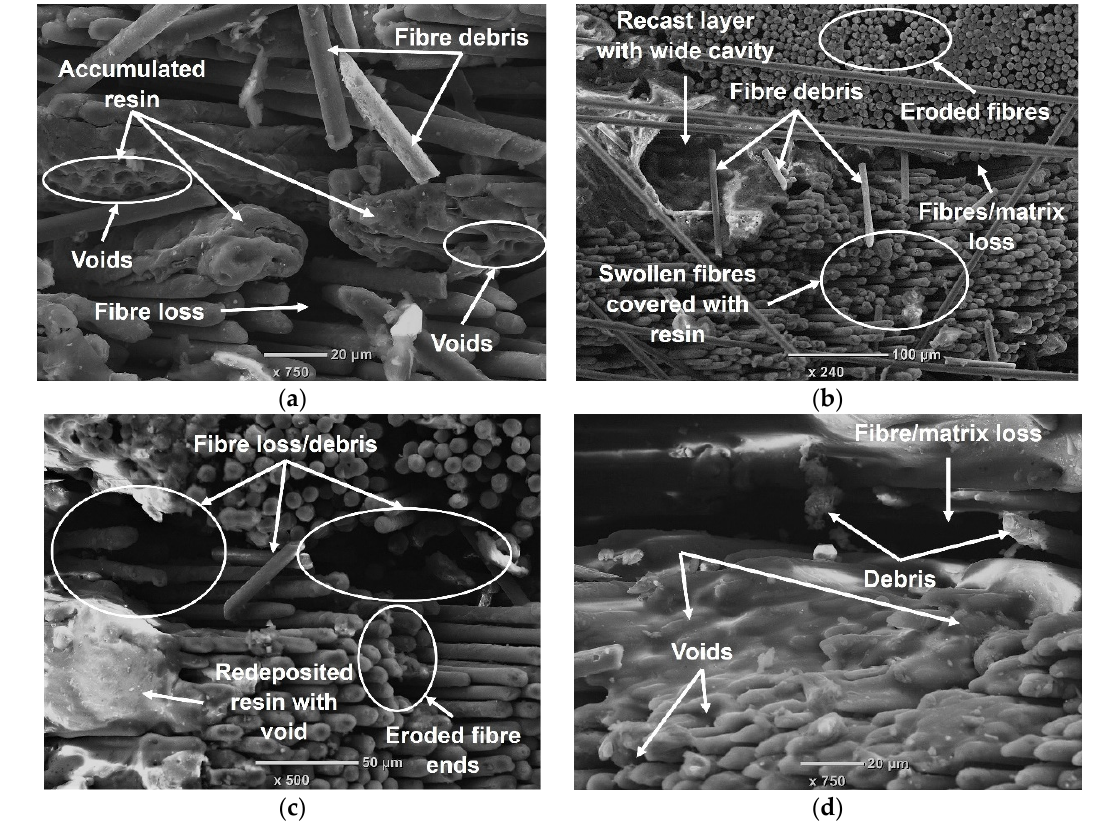
Figure 8. Sample SEM micrographs of surfaces machined using the Topas wire in ( a ) Test 3 and ( b ) Test 2 and Compeed wire in ( c ) Test 7 and ( d ) Test 6.